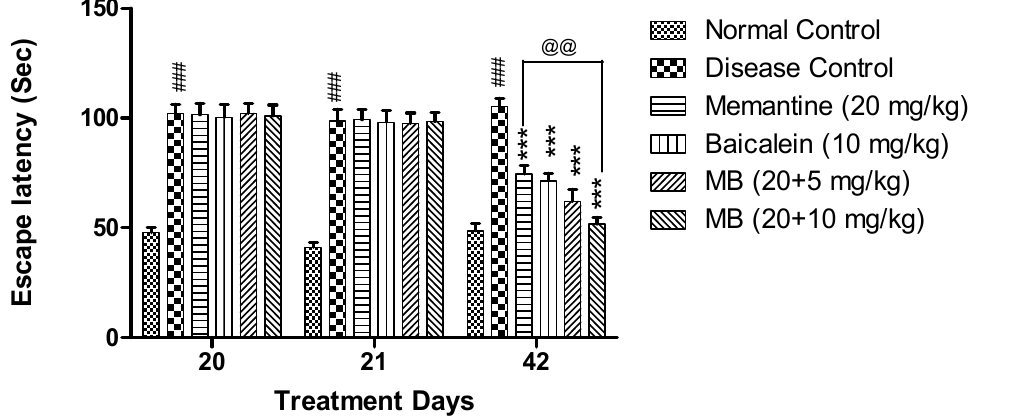
Figure 2. Morris water maze—The escape latency of each treatment group was plotted against treat- ment days (20, 21 and 42 days). Data are shown as mean ± SEM (n = 6) at p < 0.05. Comparison with normal control is indicated with ### p < 0.001, whereas comparison with disease control is indicated with *** p < 0.001 and @@ p< 0.01 indicate comparison with memantine treatment group. MB: me- mantine + baicalein. Figure 3. Elevated Plus maze—The transfer latency of each treatment group was plotted against treatment days (20, 21 and 42 days). Data are shown as mean ± SEM (n = 6) at p < 0.05. Comparison with normal control is indicated with ### p < 0.001, whereas comparison with disease control is